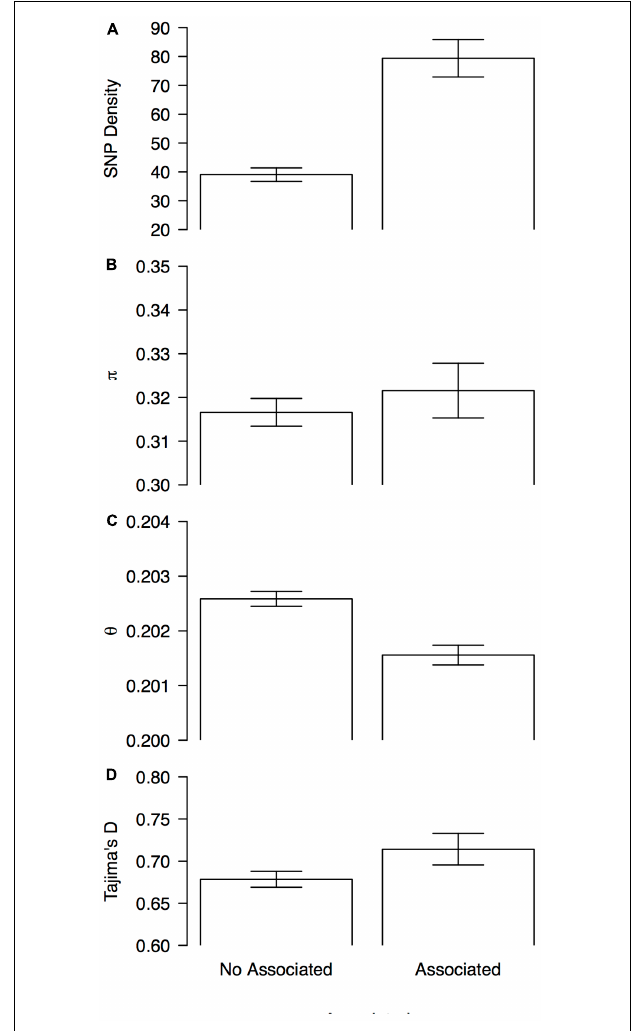
FIGURE 5 | Patterns of genome-wide diversity in genomic windows associated and no associated with drought tolerance. Means and 95% permutation-based confidence intervals are shown for (A) SNP density, (B) nucleotide diversity as measured by π , (C) Watterson’s theta estimator ( θ ), and (D) Tajima’s D, when computed in sliding windows (window size = 1 × 10 6 bp, step size = 200 kb) that contained (associated) or did not contained (no associated) at least one marker that was associated with the bioclimatic-based drought index ( Figure 4